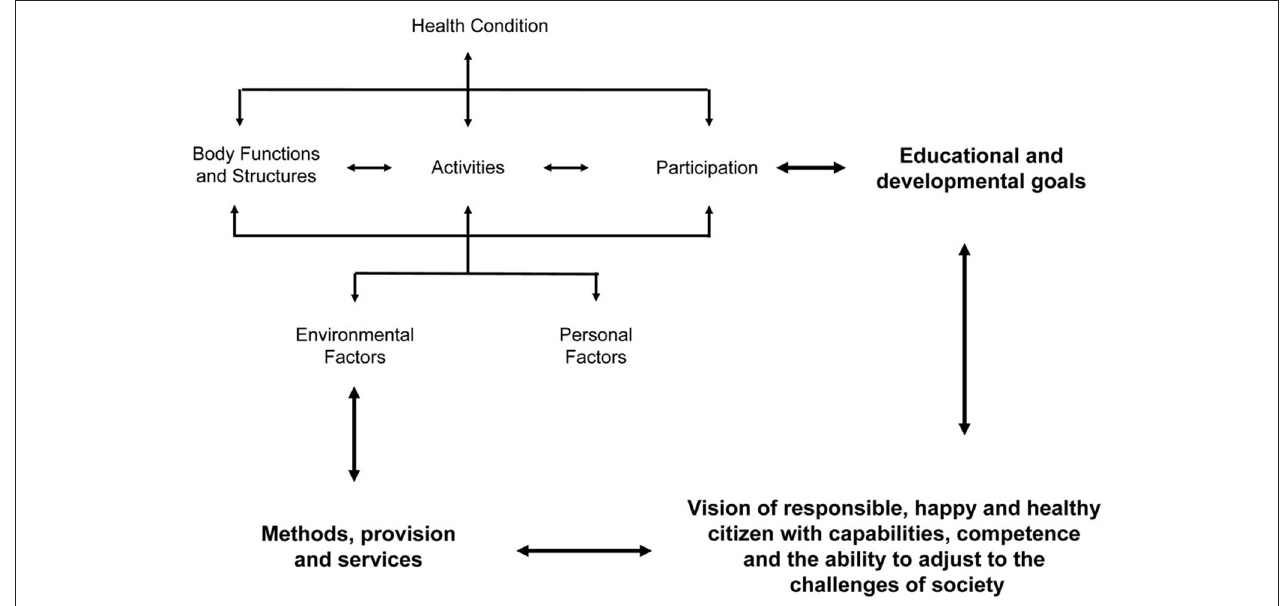
FIGURE 3 | Hollenweger’s modified ICF/ICF-CY model (Hollenweger, 2011, p.